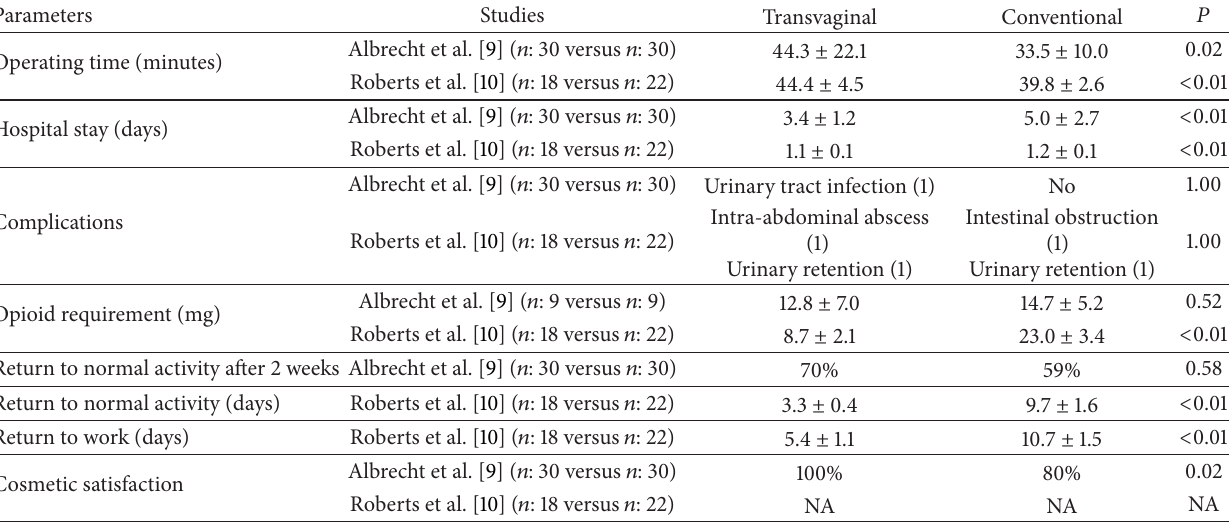
Table 5: Comparison of transvaginal and conventional laparoscopic